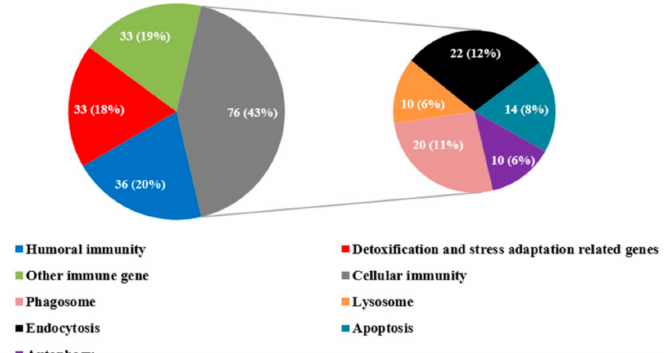
Figure 3. The distribution of immune-related DEGs in the categories of humoral immune, detoxifica- tion and stress adaptation-related genes, cellular immunity (phagocytosis, endocytosis, apoptosis, and autophagy)-related genes, and other immune-related genes. The number (percentage) of each category of immune-related genes are shown in each pie chart. All of the mentioned genes are shown in the context and Table